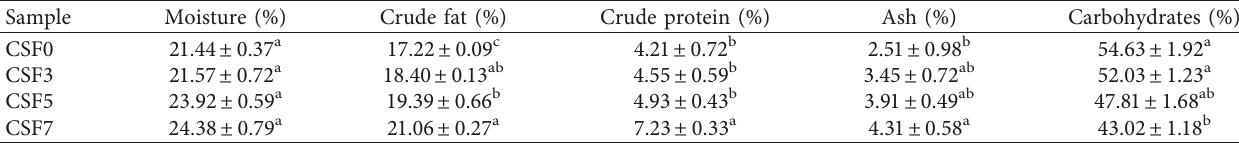
Table 2: Proximate analysis of cake that had chia seed flour added (CSF).